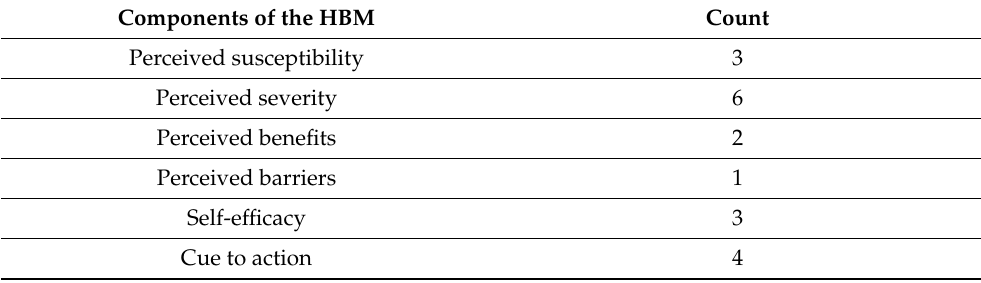
Table 7. Valid types of HBM models.